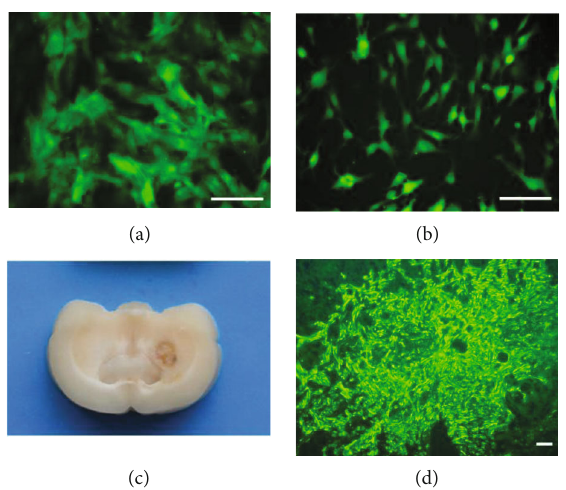
Figure 2: Induction and transplantation of MSCs. (a) Cultured MSCs labeled with GFP. Scale bar = 100 μ m . (b) MSCs induced by neuronal induction medium. Scale bar = 100 μ m . (c) The hemorrhagic area in the basal ganglia of the ICH model. (d) Transplanted MSC-dNLCs/GFP in the brains of ICH rats. Scale bar = 100 μ m